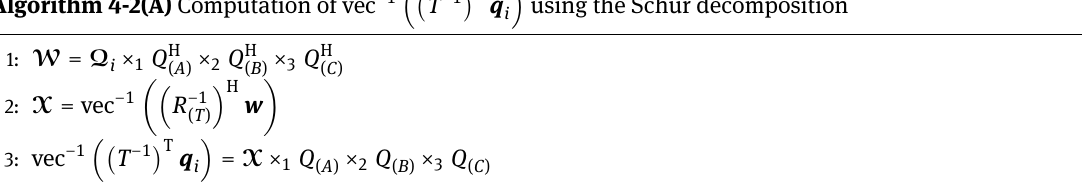
(cid:16)(cid:0) (cid:17) (cid:1) T q T −1 using the Schur i